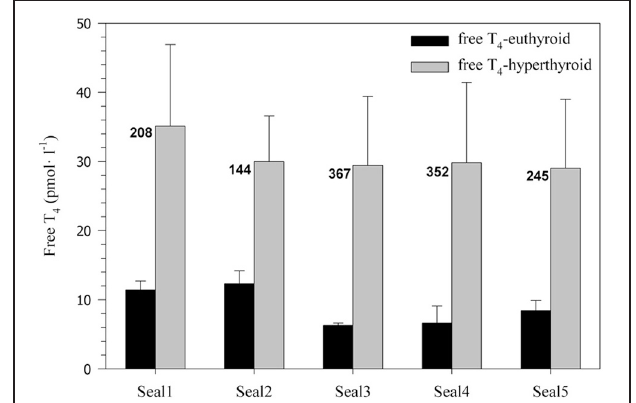
FIGURE 1 | Free serum T 4 concentration (pmol · l − 1 ) before and after experimentally induced hyperthyroidism in five harbor seals (values are means ± SD; n = 6 samples per seal and condition). Numbers beside the bars indicate the percent increase in free T 4 levels associated with levothyroxine